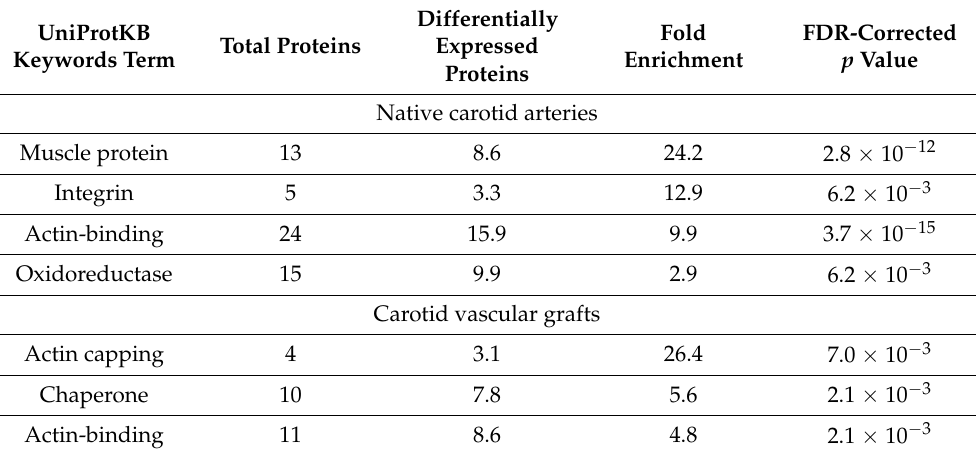
Table 5. Molecular functions of proteins which are upregulated in either native carotid arteries or TEVGs (annotated according to the UniProtKB Keywords